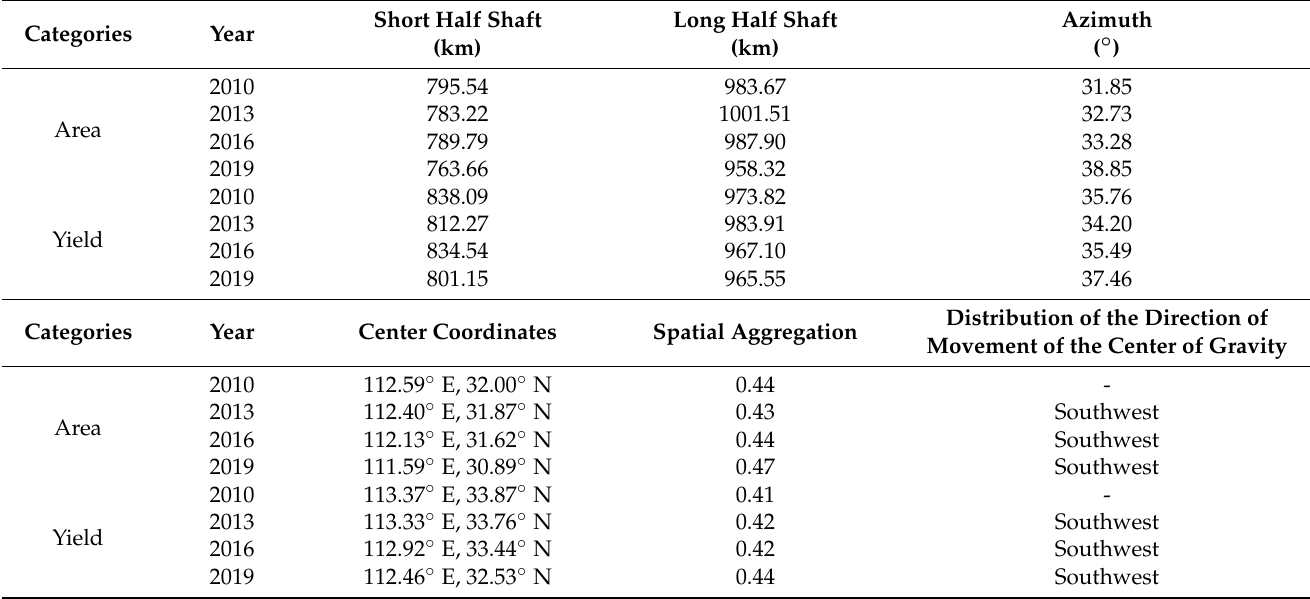
Table 2. Standard deviation ellipse-related parameters of the Chinese vegetable